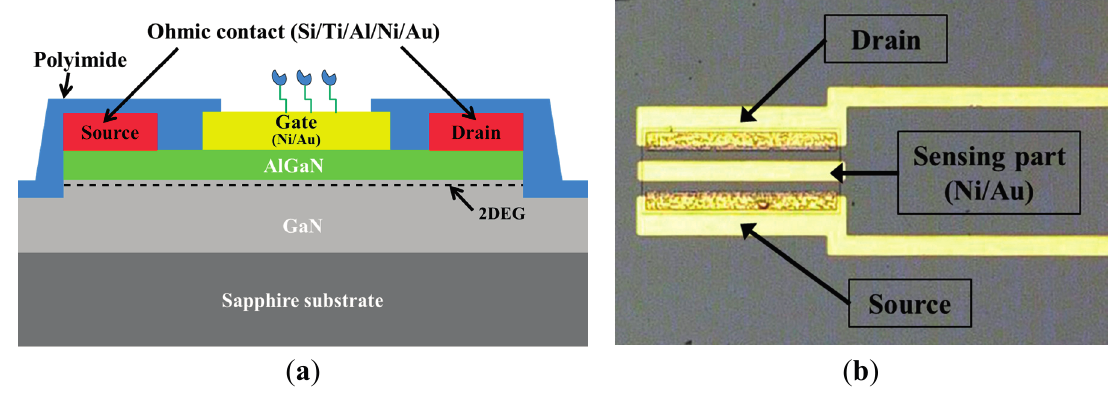
Figure 1. ( a ) Schematic of the AlGaN/GaN HEMT-based biosensor; ( b ) Photograph of the fabricated AlGaN/GaN HEMT-based